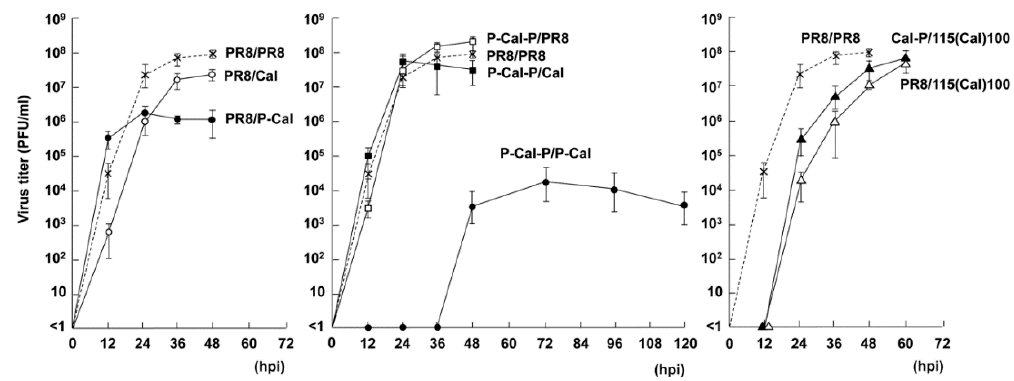
Figure 4. Growth kinetics of RG viruses with chimeric HA and NA. MDCK-SIAT1 cells were infected with RG viruses at a MOI of 0.01 and incubated at 34 °C. The culture media were harvested every 12 h, and virus titers were measured by plaque assay. Data are the means with standard deviations from three independent experiments.